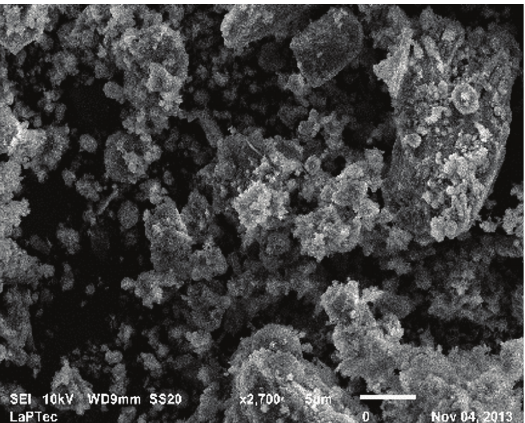
Figure 1. SEM micrograph of dried red mud.